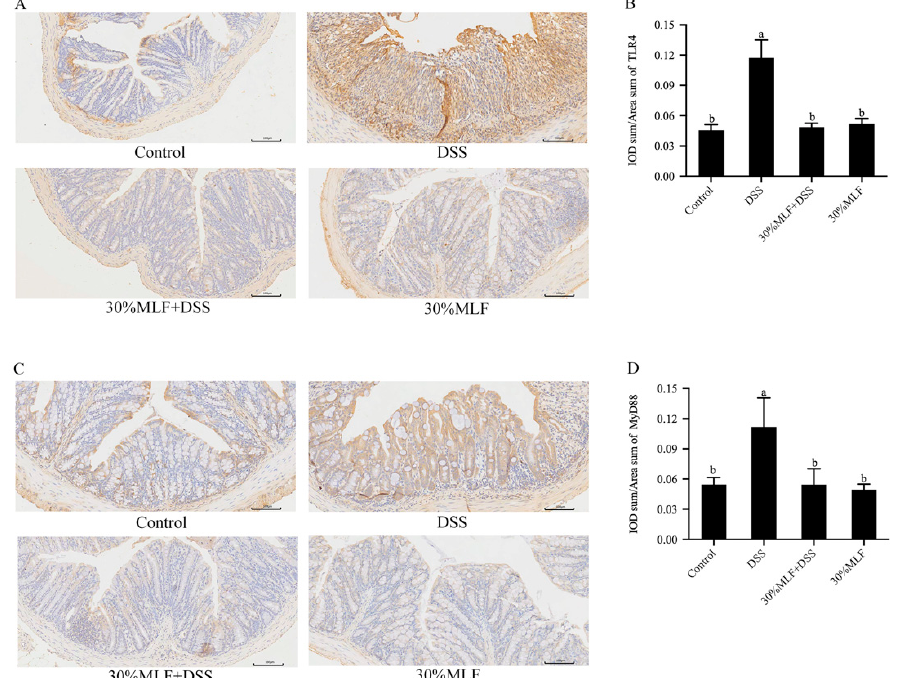
Figure 10. Effects of 30%MLF on the immunohistochemical analysis of ( A , B ) TLR4 and ( C , D ) MyD88 in the colon tissue of mice in DSS-induced UC. The average positive area from three randomly selected regions was calculated using Image-Pro Plus 6.0 software. Data are presented as the means ± SD ( n = 3). Columns with different superscript letters are significantly different ( p < 0.05).